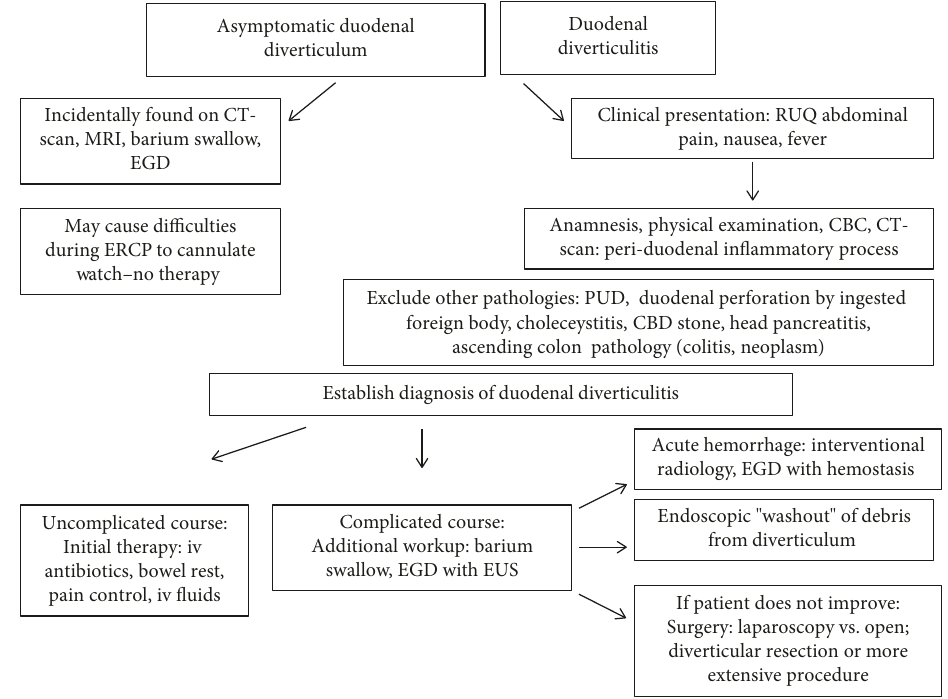
Figure 3: Algorithm on how to diagnose and manage duodenal diverticulosis and